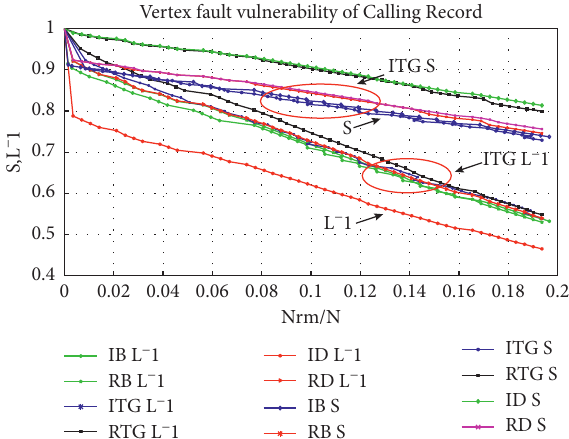
Figure 15: l − 1 & S result of Calling